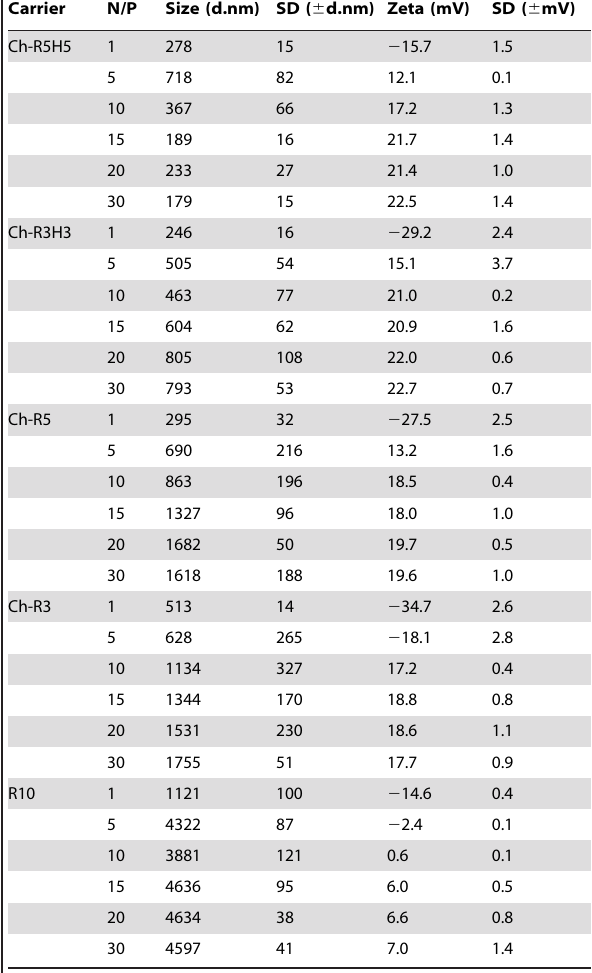
Table 1. Hydrodynamic size and zeta potential of Ch-R5H5/ DNA, Ch-R3H3/DNA, Ch-R5/DNA, Ch-R3/DNA and R10/DNA